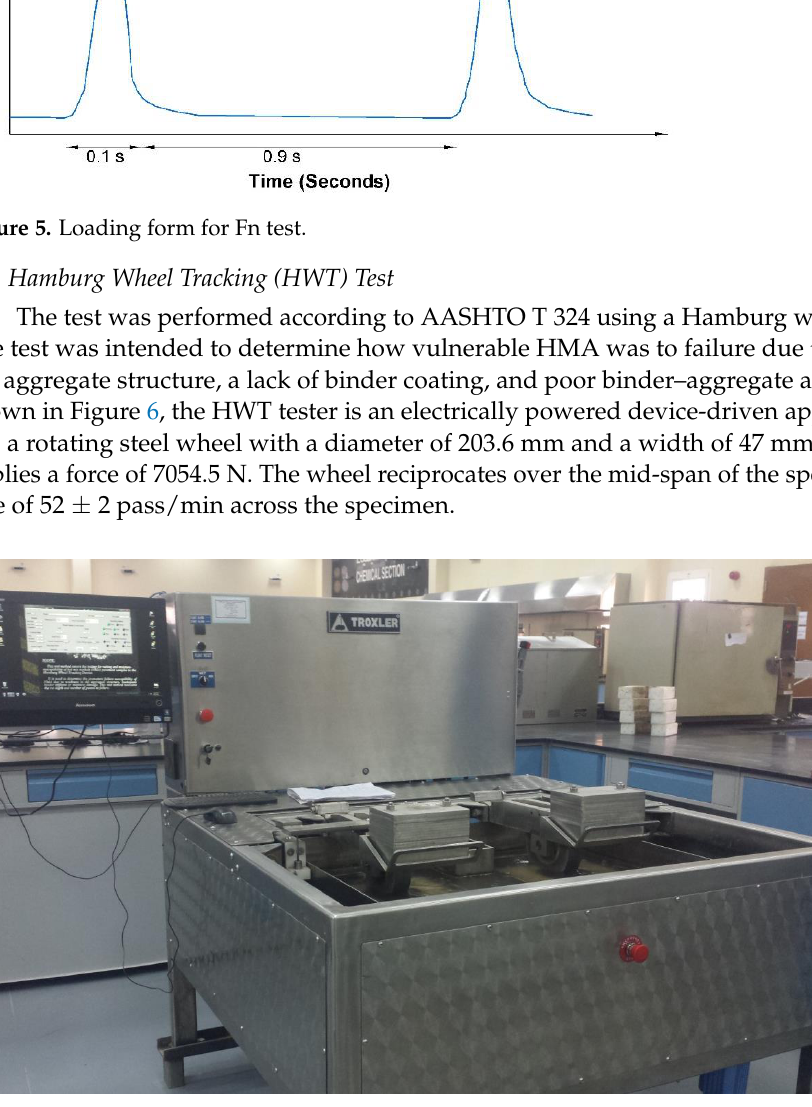
( c ) Figure 4. Preparation of test specimens ( a ) compacted specimens, ( b ) Cored specimens, ( c ) ends cut specimens. 4.2. Flow Number (Fn) Permanent deformation characteristics of HMA mixtures under repeated loading can be determined by using the Fn test. Fn is defined as the number of load cycles correspond- ing to the minimum rate of change of permanent axial strain during a repeated load [63]. A high Fn value indicates better rutting resistance. The Fn test was conducted using the asphalt mixture performance tester (AMPT) according to the test method described in NCHRP Report 513 [64]. The cylindrical asphalt specimens were subjected to several thou- sand loading cycles, and the cumulative permanent deformations were recorded as a function of loading cycles. The load was a repetitive vertical axial stress of 600 kPa for 0.1 s, followed by a rest period of 0.9 s, as shown in Figure 5. The test was conducted at a temperature of 76 °C, equal to the pavement’s high service temperature. The failure crite-